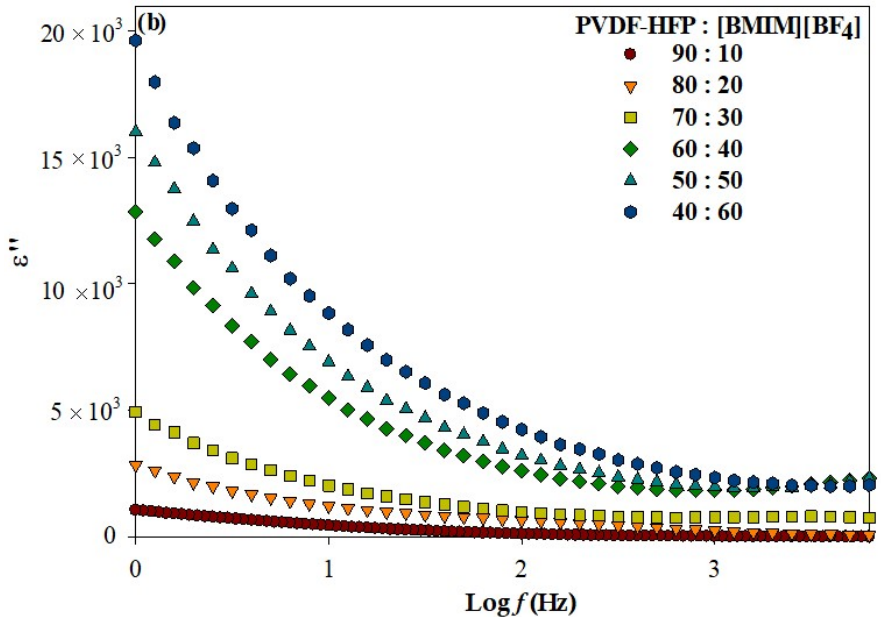
Figure 2. Frequency dependence of ( a ) dielectric constant and ( b ) dielectric loss for different percentage ratios of PVDF-HFP to [BMIM][BF 4 ].